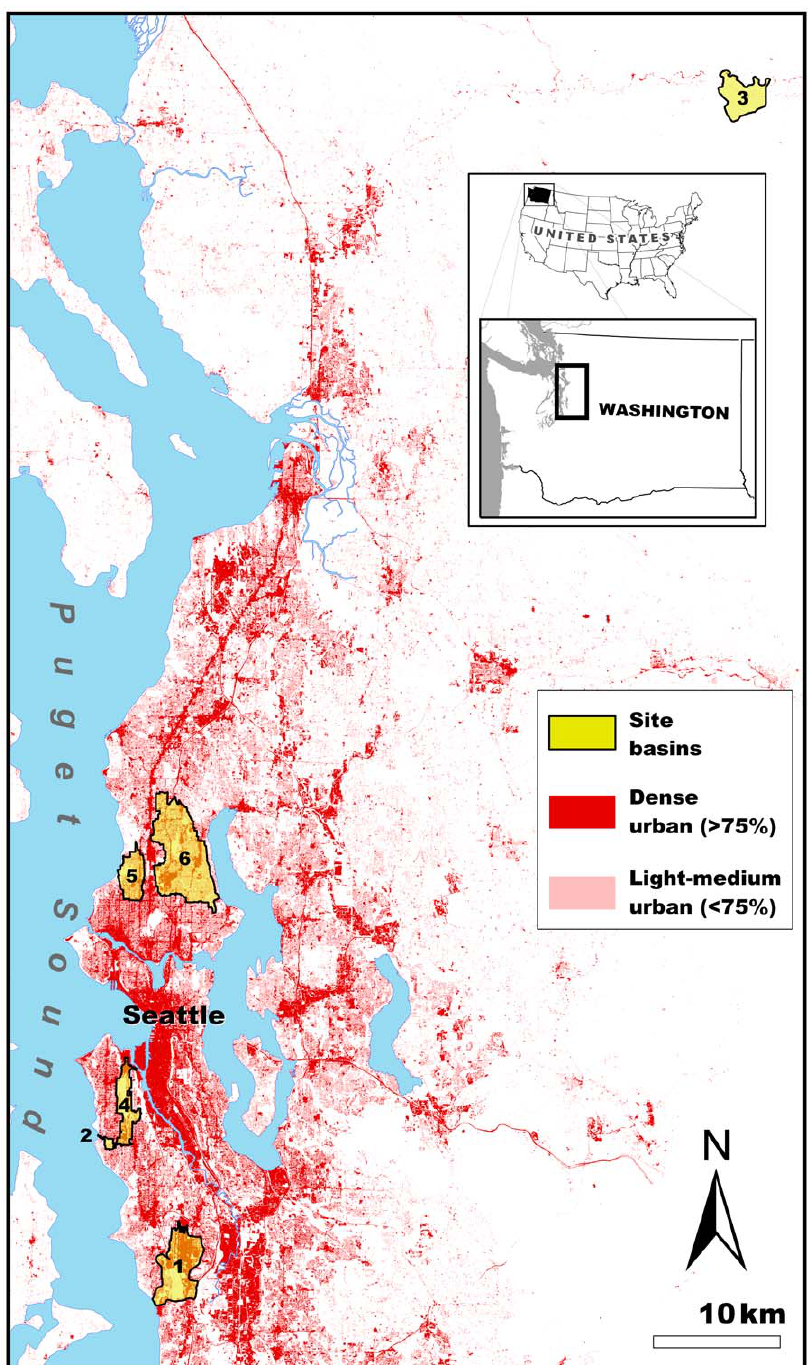
Figure 1. Six study sites where coho spawner mortality was monitored and landscape conditions were quantified. Main map depicts the Greater Seattle Metropolitan Area in Washington State, which is within the Puget Sound/Georgia Basin of the Pacific Northwest, United States of America (USA). Inset map illustrates location of the study sites within Washington State and the location of Washington State within the USA. For reference, red shading on main map represents the relative intensity of urbanization (light-medium and dense urban [23,24]). Drainage basins depicted in yellow shaded polygons represent the total basin flowing into a given stream reach site. Key for site numbers: 1=Des Moines; 2=Fauntleroy; 3=Fortson; 4=Longfellow; 5=Piper’s; and, 6=Thornton Creek.